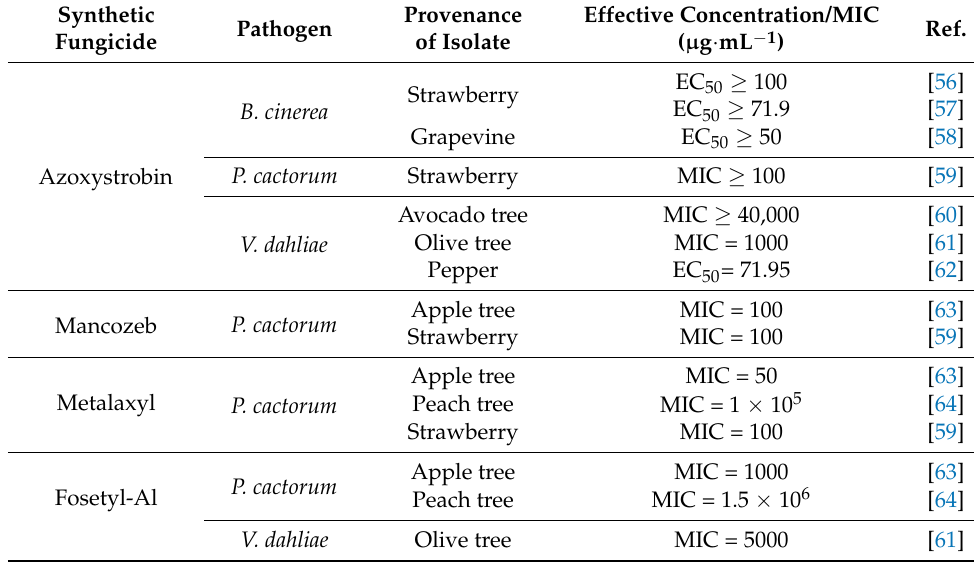
Table 7. Effective concentrations/MIC values reported in the literature for four conventional fungi- cides against the three pathogens under